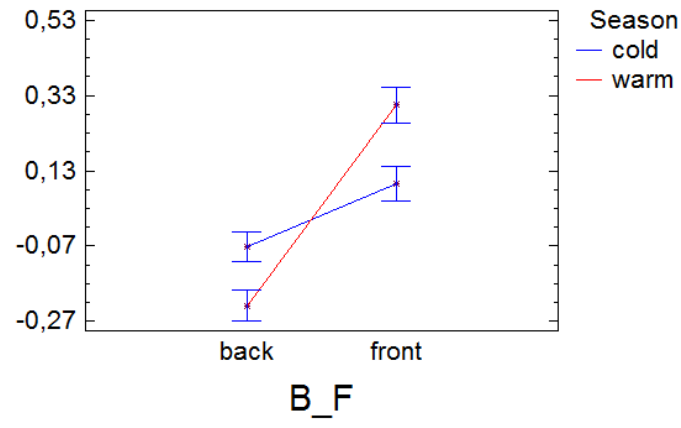
Figure 3. Interaction plot of the factors orientation (B/F) and season (cold = blue, warm = red), for the ANOVA analysis of the differences to the average temperature (residuals of an ANOVA of the temperature and the factor